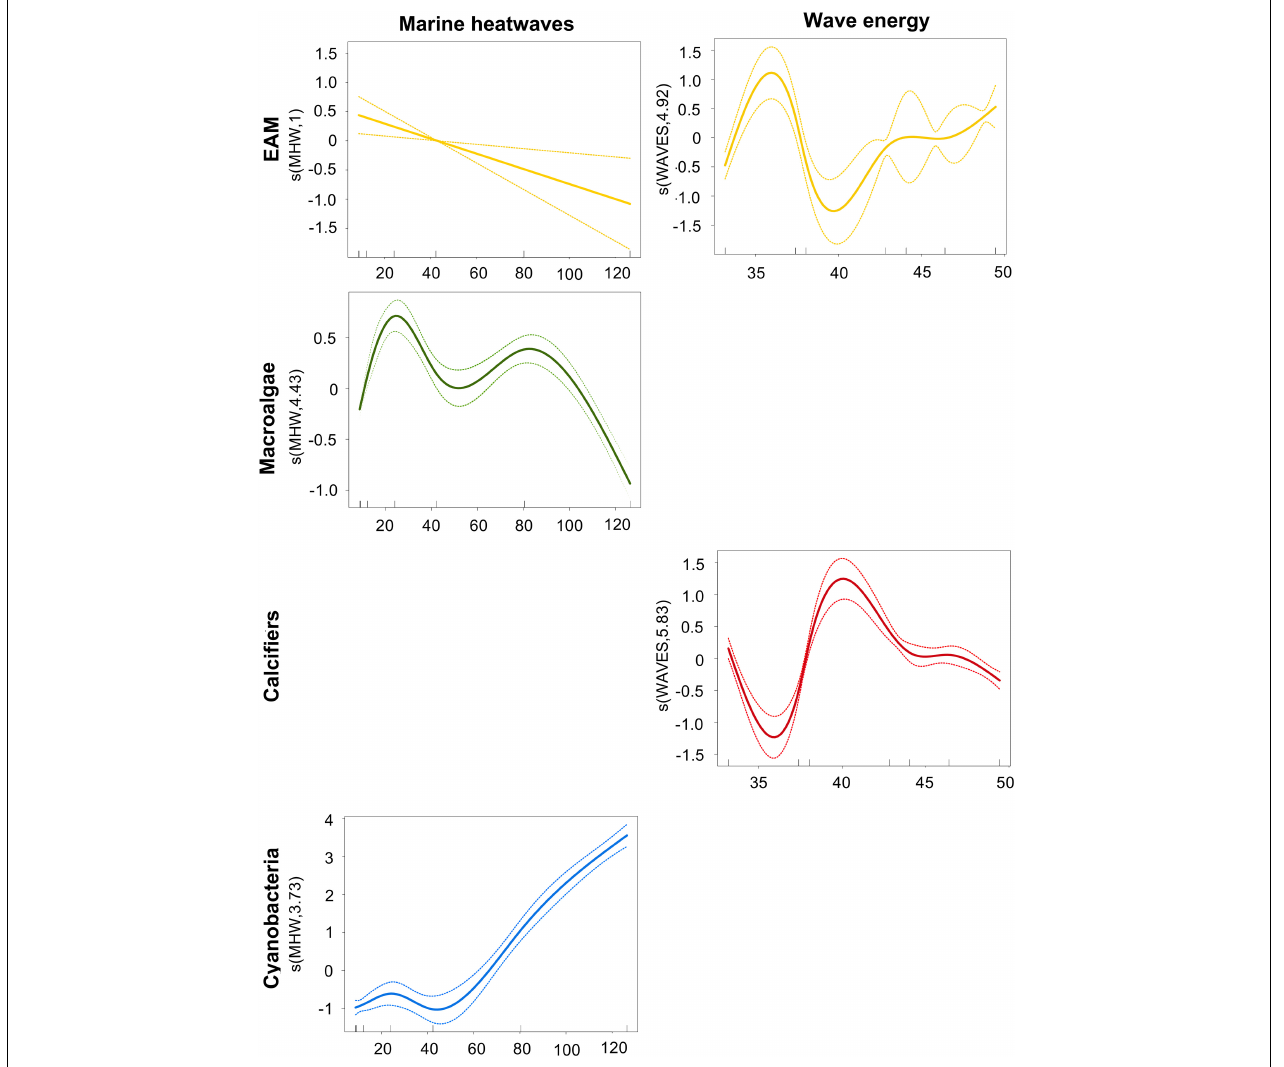
FIGURE 6 | Benthic groups responses to oceanographic parameters. Generalized Additive Mixed Models plots for epilithic algal matrix (EAM; yellow), macroalgae (green), calcifiers (red) and cyanobacteria (blue) indicating their responses to “marine heatwaves” and “wave energy” over the 7-year monitoring in Fernando de Noronha Archipelago. The x axis represents the explanatory variable gradient (interval between the lower and the higher value found for “marine heatwaves” ( ◦ C) and “wave energy” (m 2 s) throughout the sampling period). The y axis represents the smoothed partial effect of each explanatory variable (“marine heatwaves” and “wave energy”) in each benthic group (EAM, macroalgae, calcifiers and cyanobacteria). The value in the parentheses in the y axis is the edf (effective degrees of freedom) and indicates if the benthic group has a linear (edf = 1) or a non-linear (edf > 1) response to the explanatory variable. Solid lines indicate fitted values and dashed lines indicate standard